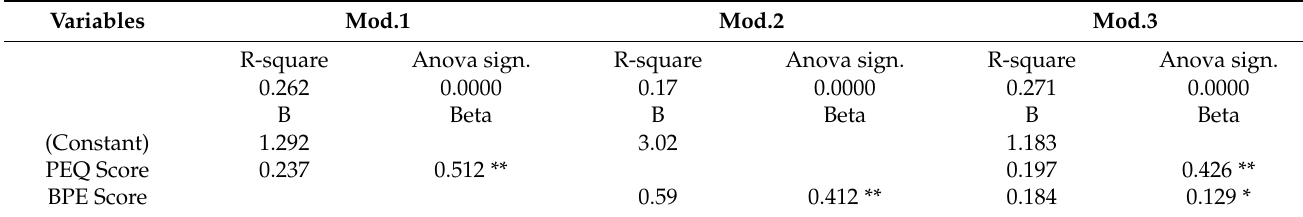
Table 4. Regression model .